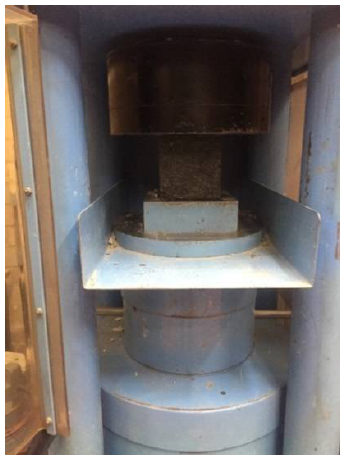
Figure 7. Compressive test setup.